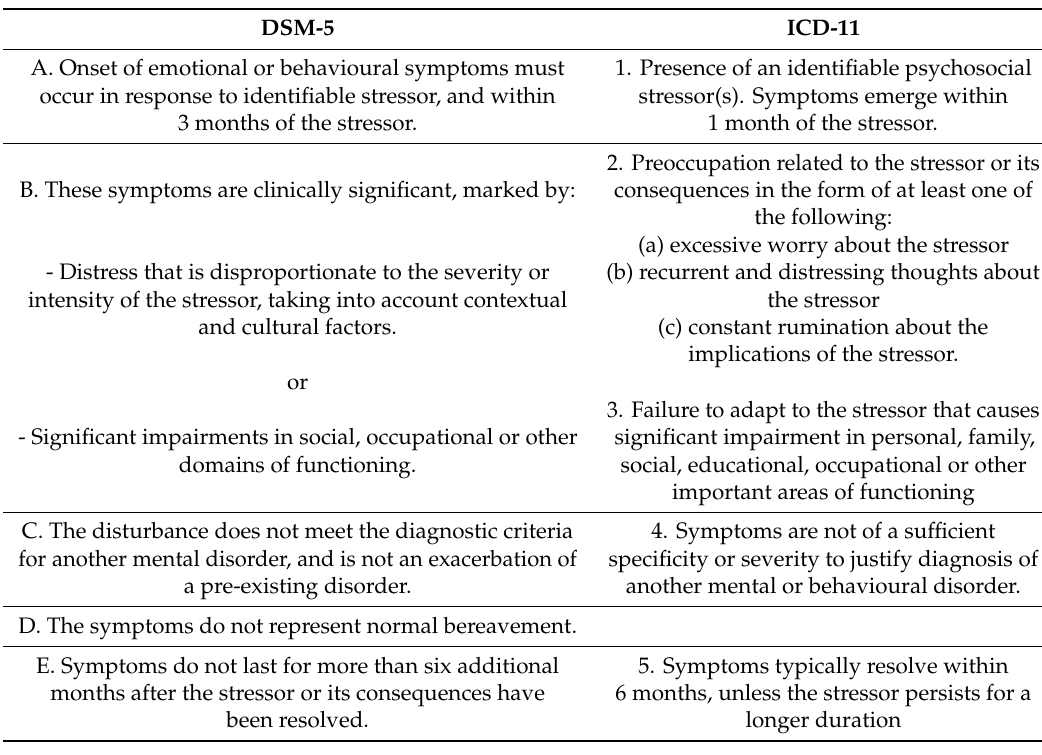
Table 1. Summary of corresponding DSM-5 [1] and ICD-11 [19] diagnostic criteria for adjustment